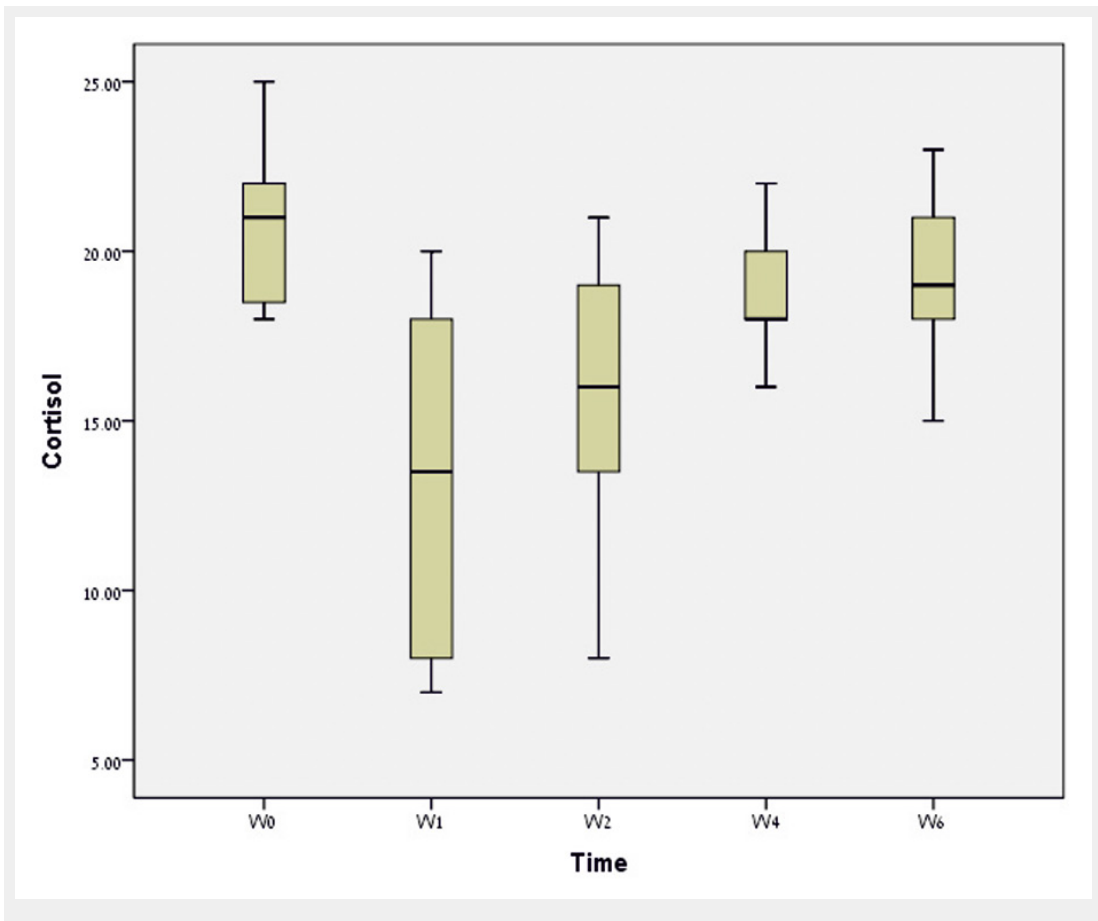
Figure 2 Poststimulation serum cortisol levels at baseline and at different time points in all the patients. Box plot showing distribution of serum cortisol levels at each time point, where the lower and upper borders of the box and the line inside it represent quartile 1 (Q1), Q3 and the median values, and the upper and lower whiskers represent Q3+ 1.5 interquartile range (IQR) and Q1-1.5 IQR, respectively. W0 = baseline; W1 = week 1; W2 = week 2; W4 = week 4; W6 = week